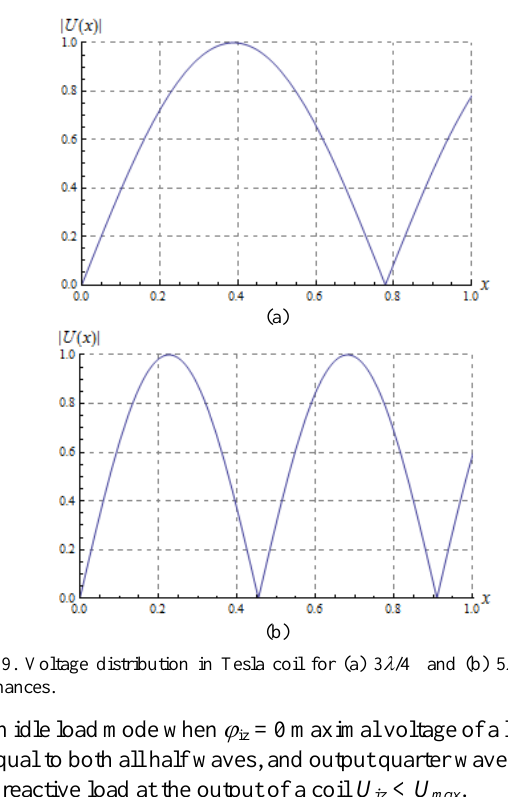
Fig. 9. Voltage distribution in Tesla coil for (a) 3  /4 and (b) 5  /4 wave resonances. In idle load mode when  iz = 0 maximal voltage of a line U max is equal to both all half waves, and output quarter wave. If there is a reactive load at the output of a coil U iz < U max